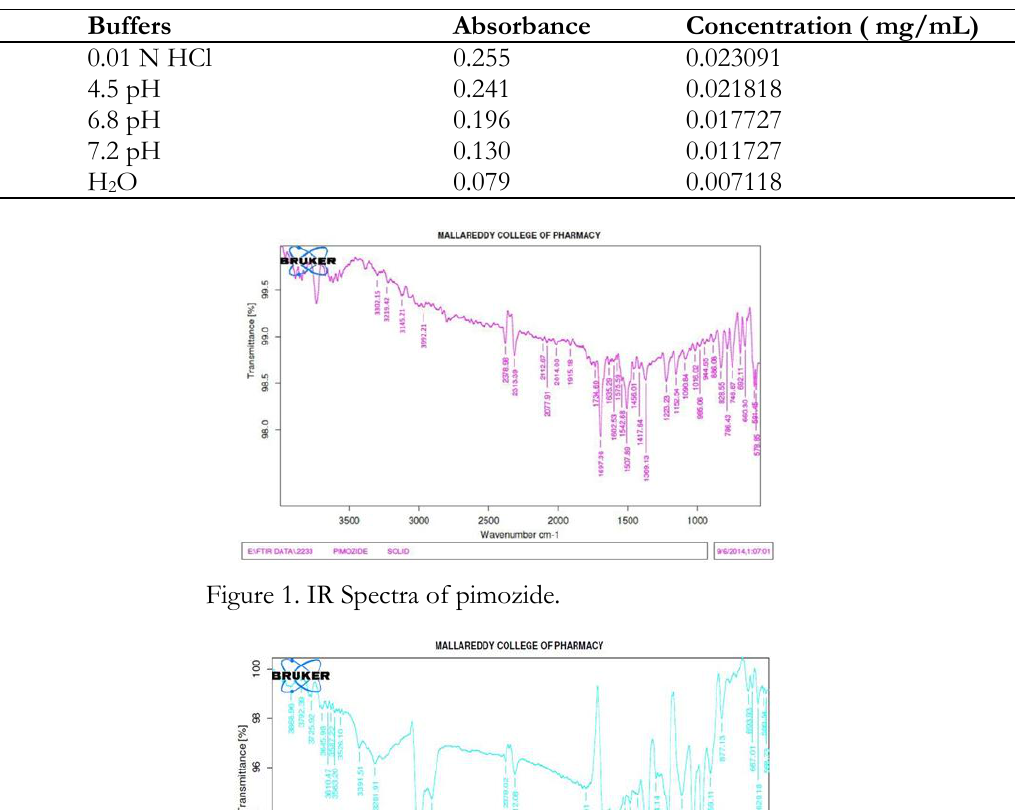
Table III. Solubility behavior of pimozide